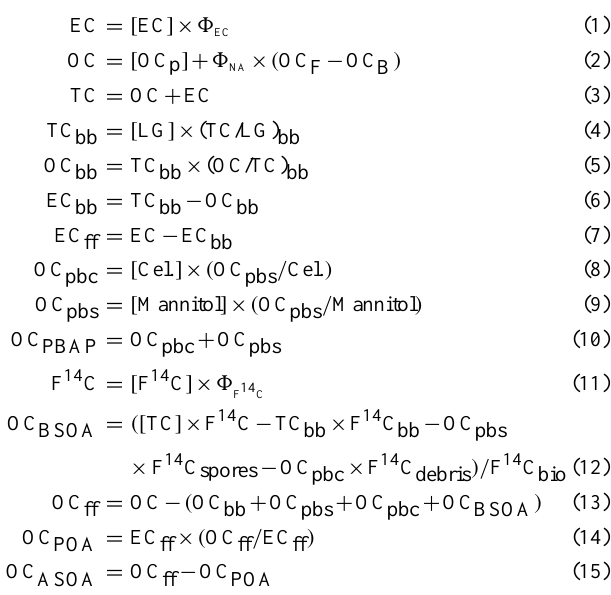
Table 2. Basis for